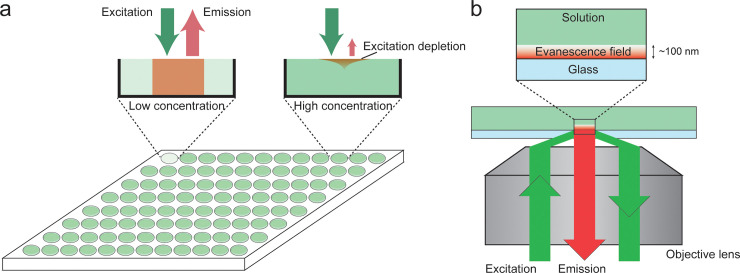
Comparison between the conventional fluorometric system and the nano-cuvette system.(a) Fluorescence measurement of solutions with low and high fluorophore concentrations in a microplate reader. Compared with solutions of low concentration in which all the fluorophores are excited (left), at high concentration, only a small portion of fluorophores near-surface are excited owing to the rapid absorption of the excitation light. (b) Schematic representation of the nano-cuvette system. The excitation beam illuminates the chamber in total internal reflection mode which generates an evanescence field with a penetration depth of ~100 nm. With this depth, the emission from all the fluorophores can be collected by the objective lends as no absorption of excitation beam occurs.